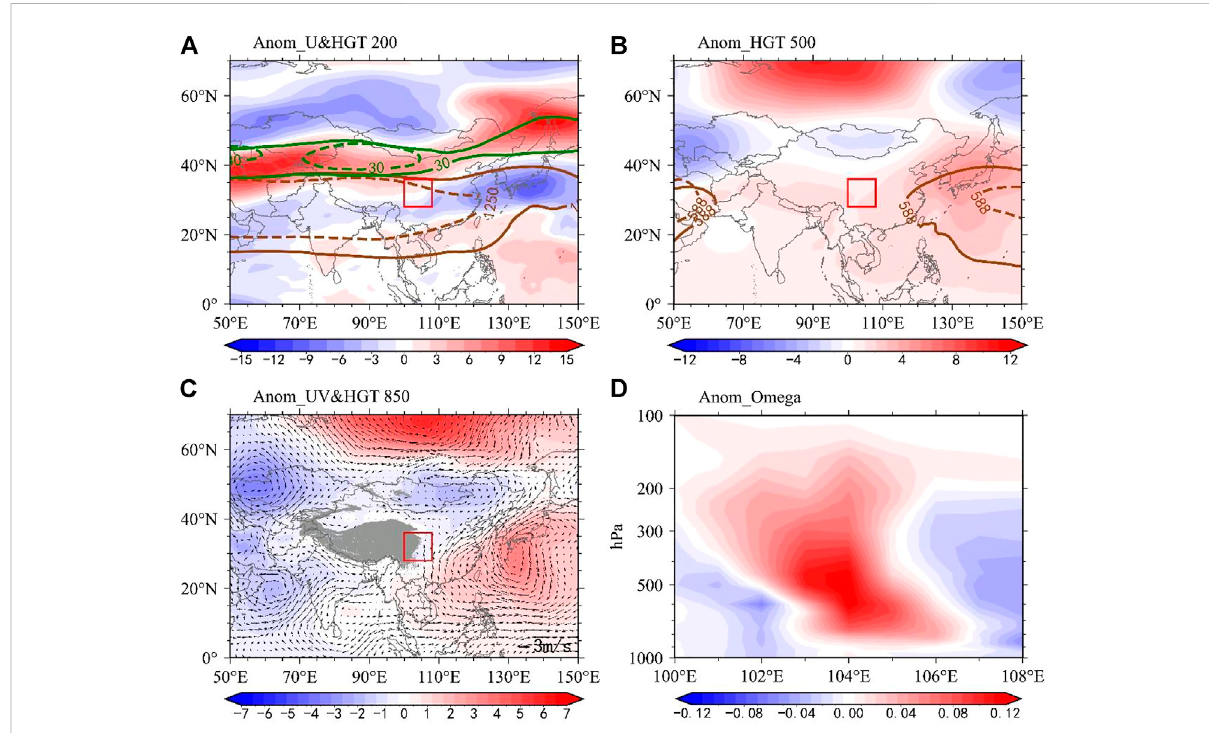
FIGURE 4 Characteristics of the anomalous atmospheric circulation in August 2020: (A) 200 hPa zonal wind anomaly (shading, Units: m · s − 1 ; the dashed andsolidgreenlinesrepresentthe30 m · s − 1 isolineintheclimatologicalmeanandAugust2020;thedashedandsolidbrownlinesarethesameasthe green lines but for the 12,500 isolines at 200 hPa); (B) 500 hPa geopotential height anomaly (shading, Units: gpm; the dashed and solid brown lines are the 5,880 isolines in the climatological mean and August 2020); (C) 850 hPa geopotential height (shading, Units: gpm) and wind fi eld anomalies (vectors, Units: m s − 1 ); (D) regional averaged vertical velocity anomalous height-longitude pro fi le (Units: 10 – 1 Pa · s − 1 ). The red rectangular frame in (A – C) shows the location of WC, and the shaded gray areas in (C) exhibit the 850 hPa